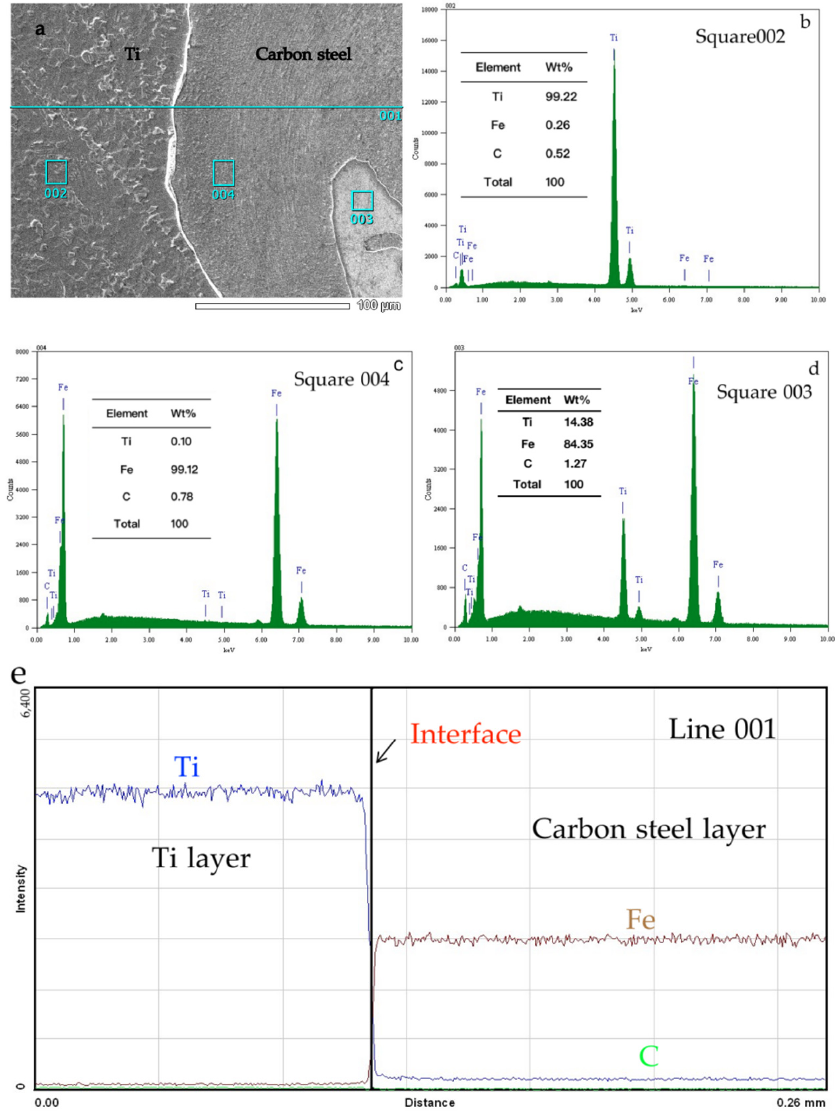
Figure 4. Microstructure and corresponding EDS results: ( a ) interface microstructure; ( b ) spot analysis of square 002; ( c ) spot analysis of square 004; ( d ) spot analysis of square 003; and ( e ) Line (001) scan analysis across the bonding interface form Ti to carbon steel.